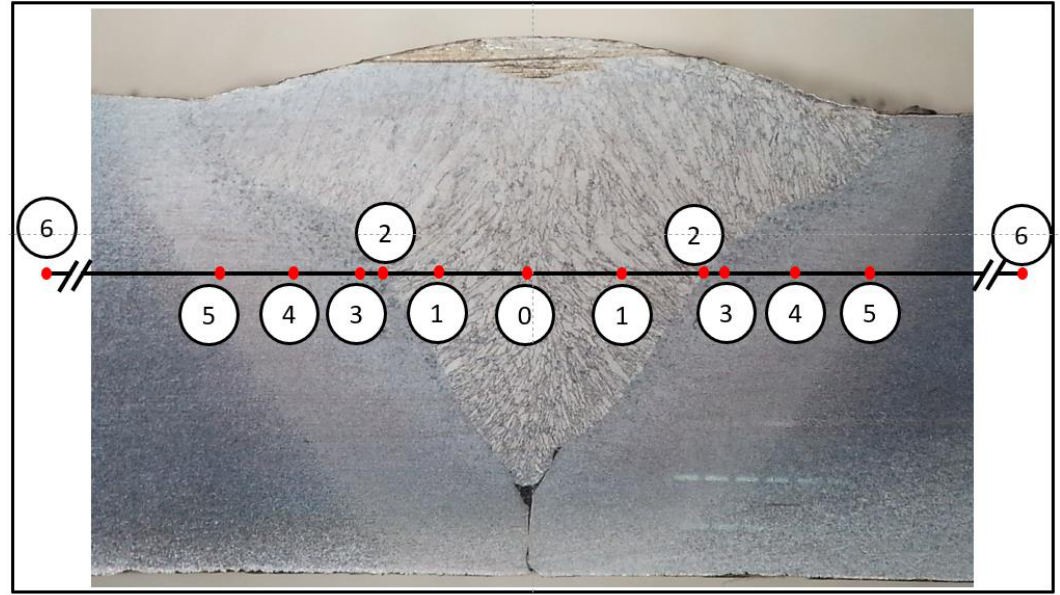
Figure 9. Position of di ff erent microhardness indents along the scan line and the corresponding microstructure.